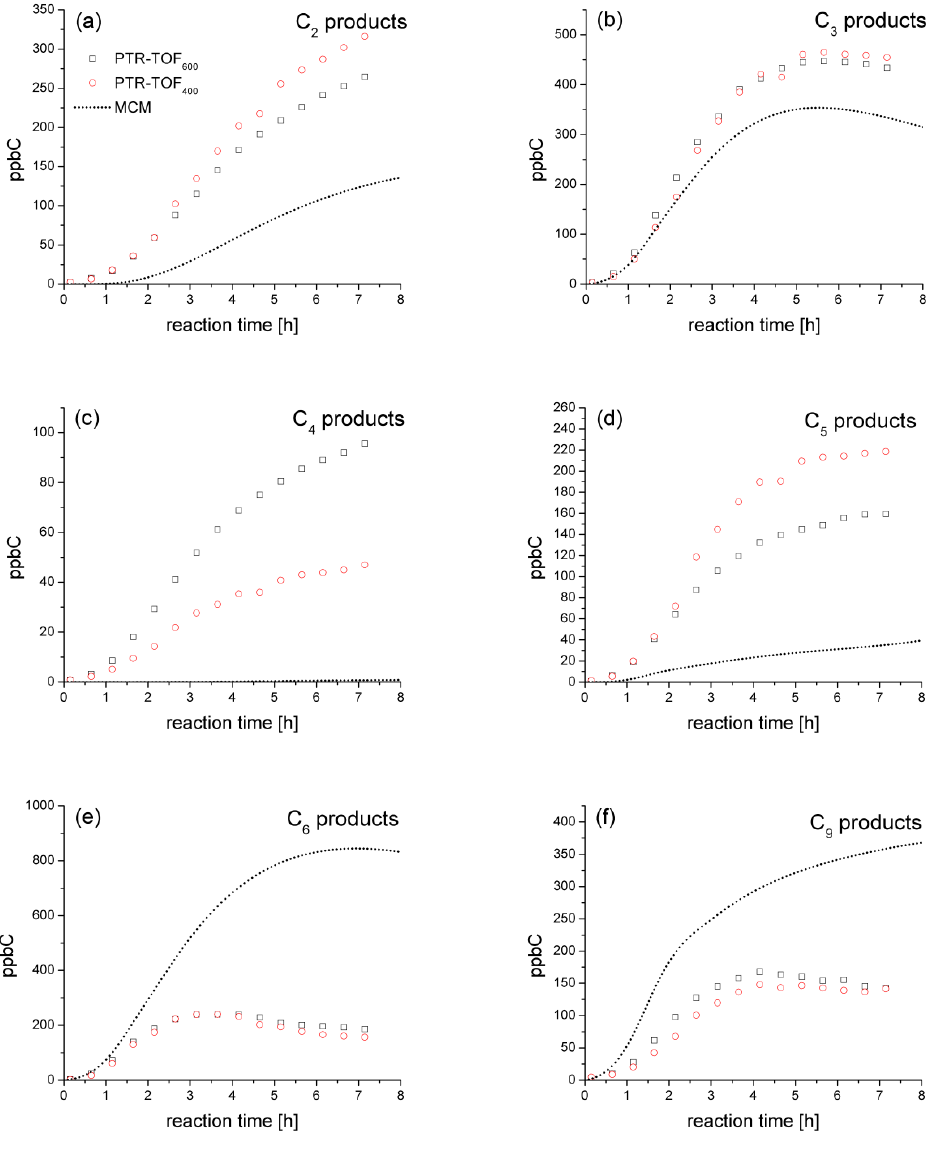
Figure 5. Time evolution of C by PTR-TOF